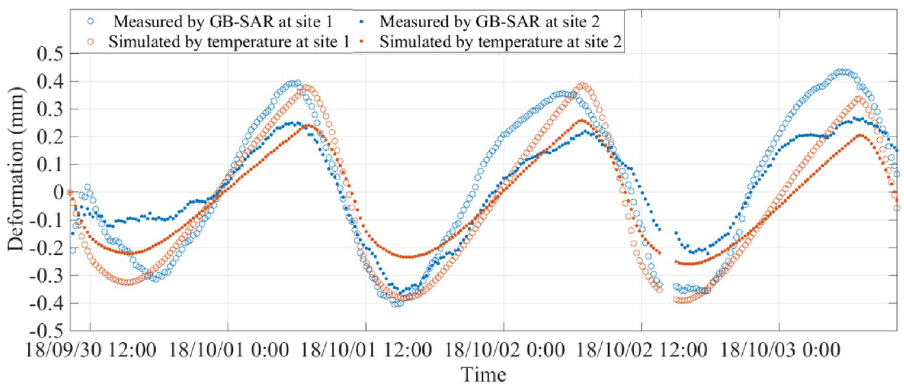
Figure 10. Deformation measured by the GB-SAR sensor at sites 1 and 2, and simulated deformation based on thermal deformation model and temperature measurements.